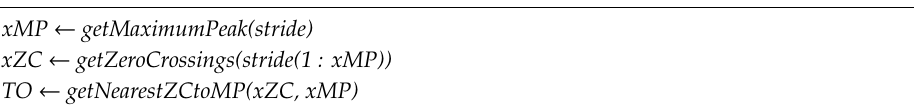
Algorithm 1: Toe-o ff (TO) detection algorithm.